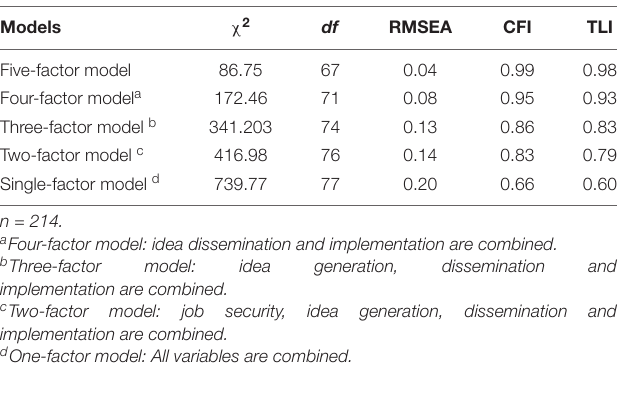
TABLE 1 | Model fit results for confirmatory factor